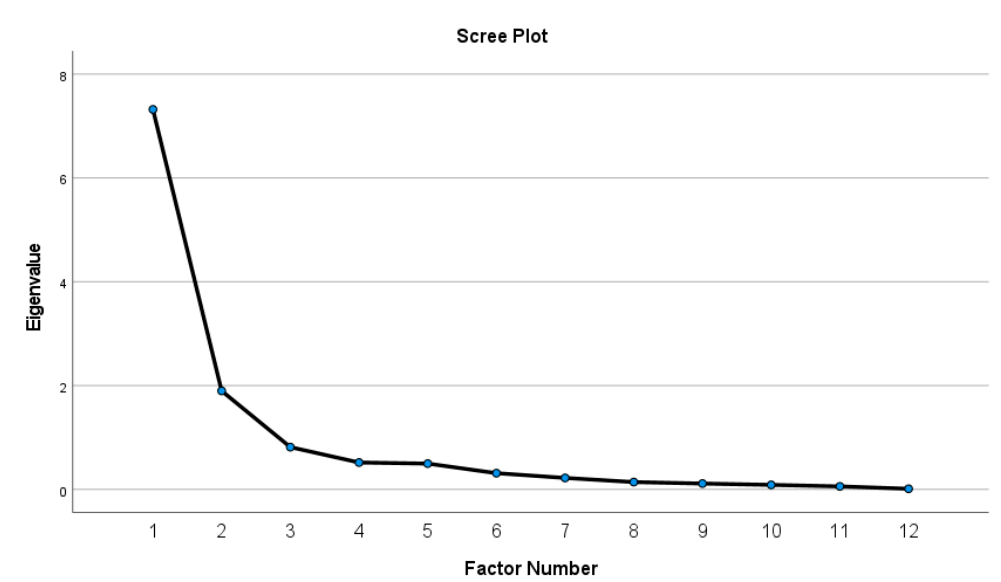
Figure 4. Scree Plot for Exploratory Factor Analysis.